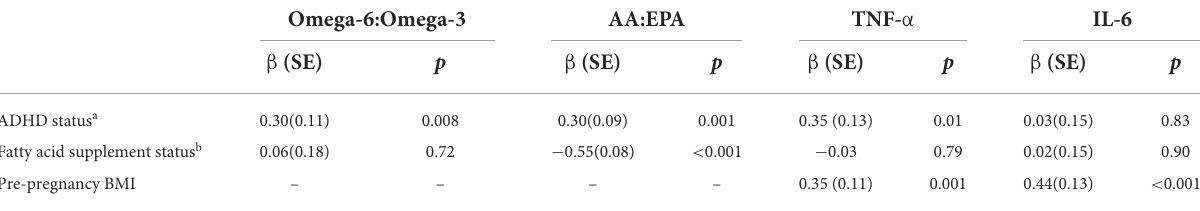
TABLE 3 Results from regression models relating ADHD status and n-6:n3 metrics and pro-inflammatory cytokines in pregnant individuals ( N = 68).